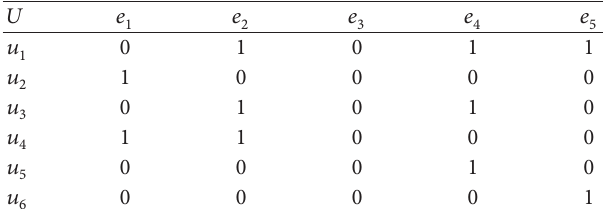
Table 1: Tabular presentation of the soft set.